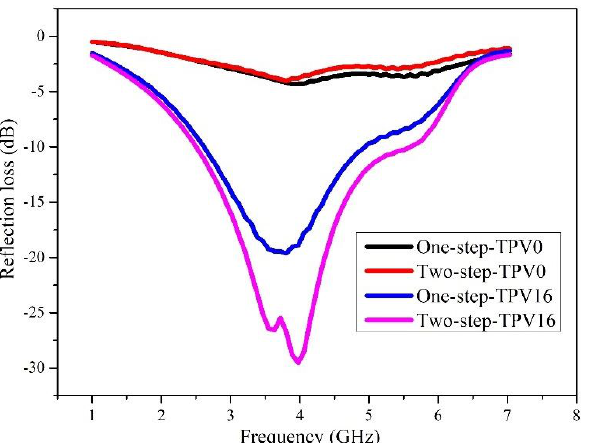
Figure 8: Reflection loss of frequency in 1~7 GHz for typical sam- ples.